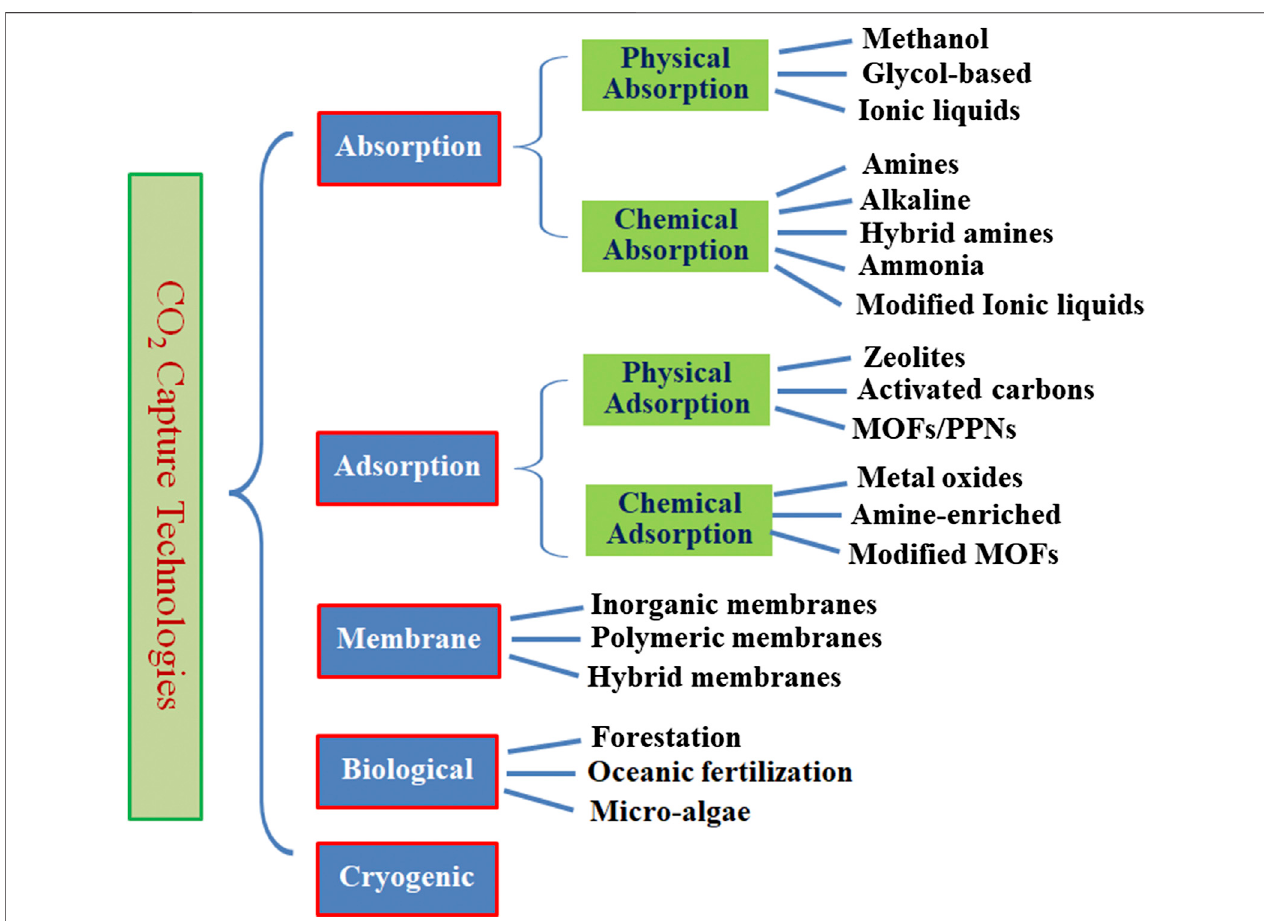
FIGURE 3 | Illustration of various CO 2 capture technologies along with typical materials currently under investigation.